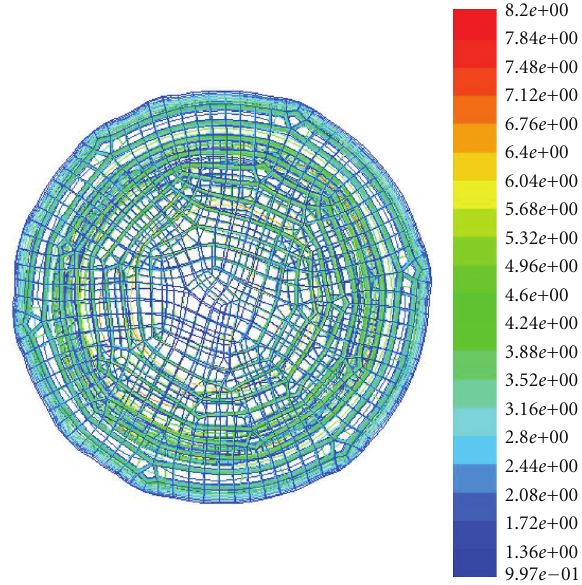
Figure 3: The gridded fluid section in the high-pressure reversing valve